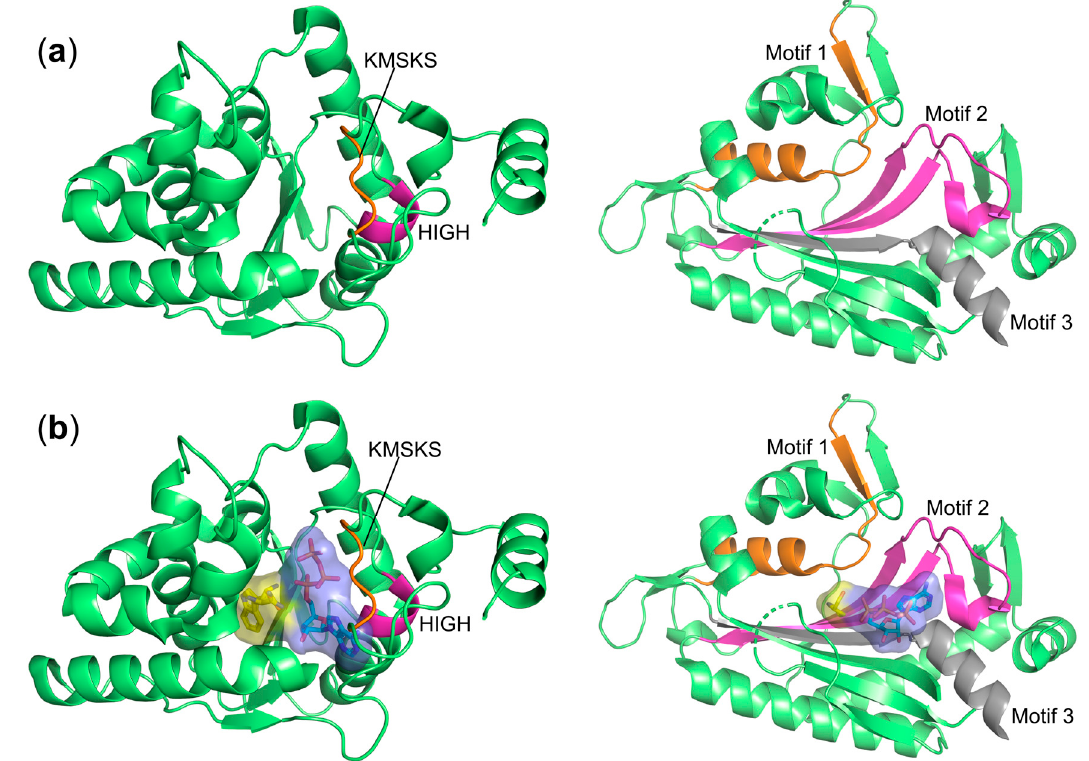
Figure 2. The architectures of the catalytic sites of class I and II aaRSs. ( a ) The catalytic domains and signature sequence motifs in class I (left) and class II (right) aaRSs. ( b ) The binding pockets of ATP and amino acid in class I (left) and class II (right) aaRSs. The crystal structure of B. stearothermophilus TrpRS (Bs-TrpRS) in complex with ATP and tryptophanamide (PDB entry: 1MAU) represents class I aaRSs while the structure of Enterococcus faecalis ProRS (Ef-ProRS) in complex with ATP and prolinol (PDB entry: 2J3M) as the representative for class II aaRSs. For clarity, we only show the catalytic domains corresponding to residues 1–221 for Bs-TrpRS and residues 19–214 and 405–456 for Ef-ProRS. Class I conserved HIGH and KMSKS sequence motifs are colored in magenta and orange, respectively. Motifs 1, 2, and 3 of the class II aaRSs are shown in orange, magenta, and grey, respectively. The binding cavities of ATP (slate) and amino acid (yellow) are shown as semi-transparent surface representations with ligands shown as sticks.